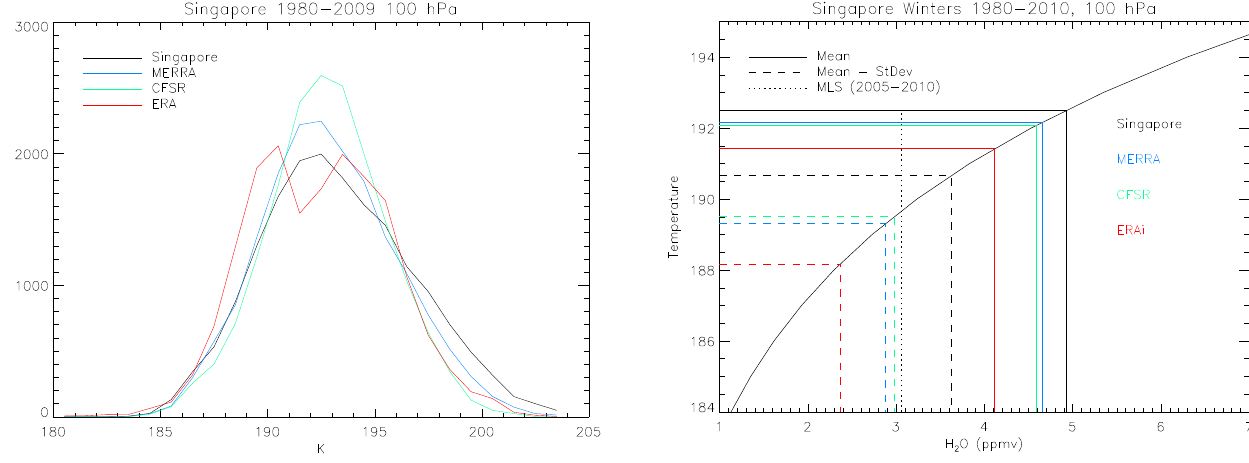
Fig. 1a. PDF of 100hPa winter (DJF) temperatures at Singapore and for the three reanalyses (with units of number of observations per K).